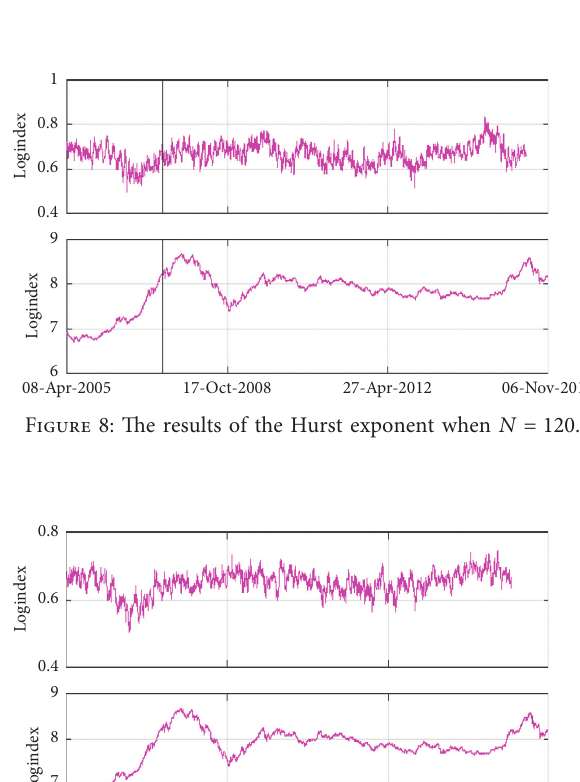
Figure 7: The results of the Hurst exponent when N � 50.